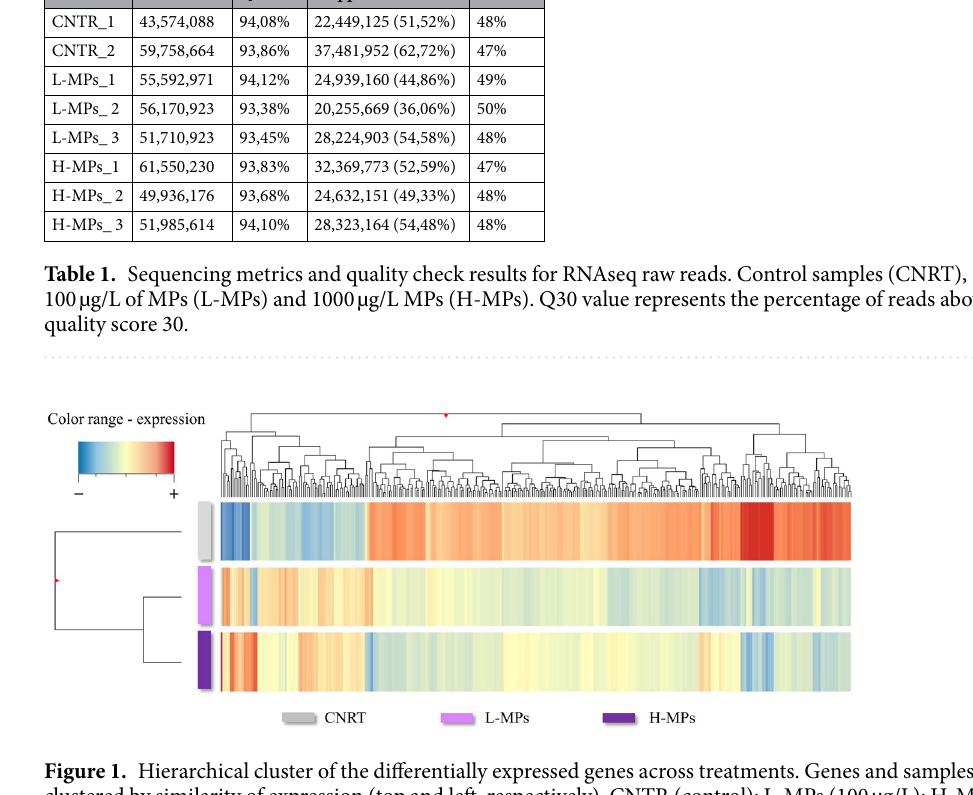
Figure 1. Hierarchical cluster of the differentially expressed genes across treatments. Genes and samples are clustered by similarity of expression (top and left, respectively). CNTR (control); L-MPs (100 µ g/L); H-MPs (1000 µ